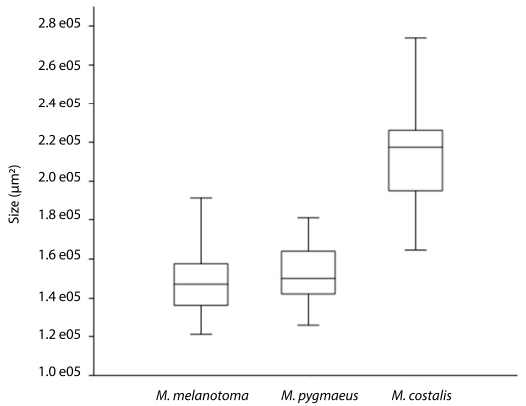
Figure 1. Dorsal view of the left paramere of M. pygmaeus ( A ), M. melanotoma ( B ) and M. costalis ( C ). Parts of the paramere: body with the sensory lobe (a) and apical process (b). The arrows show body shape differences between species.